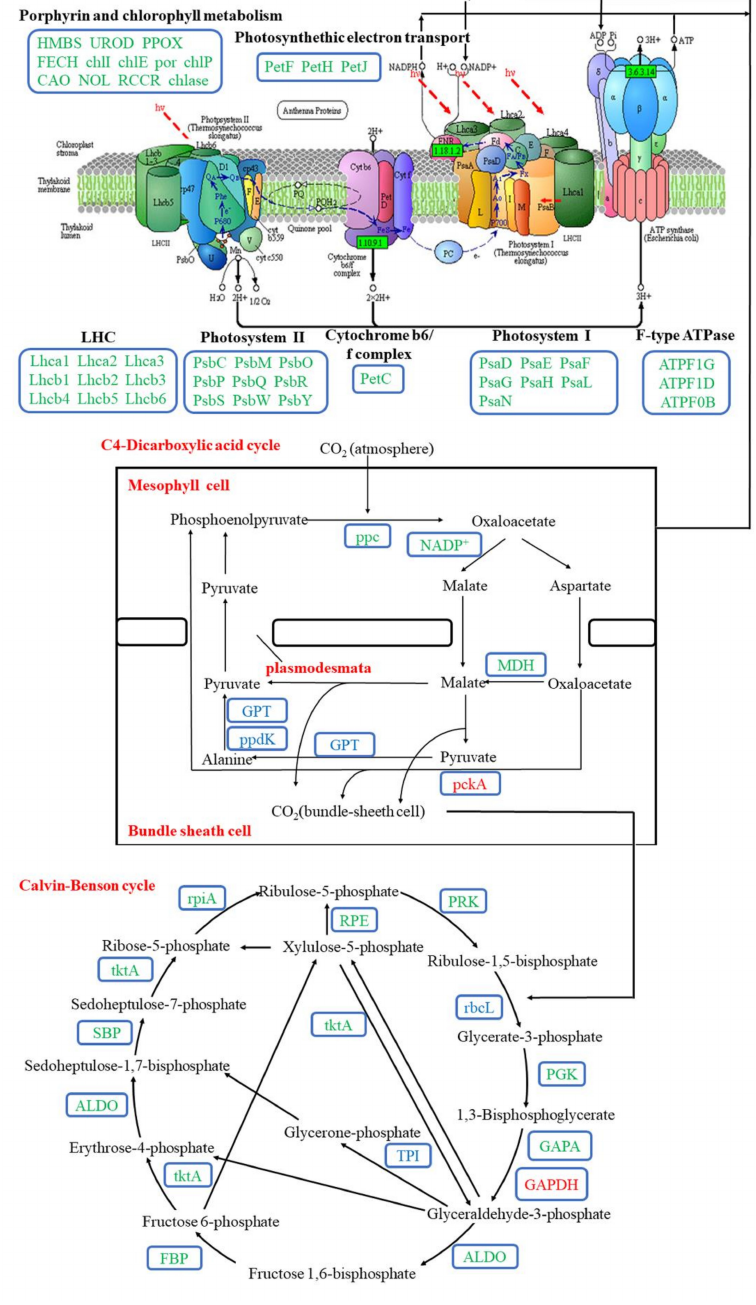
Figure 3. The co-expression of differentially expressed genes (DEGs) related to photosynthetic path- ways in aboveground tissues of bermudagrass under shallow submergence (SS) and deep submergence (DS). Red letters represent up-regulated expression; green letters represent down-regulated